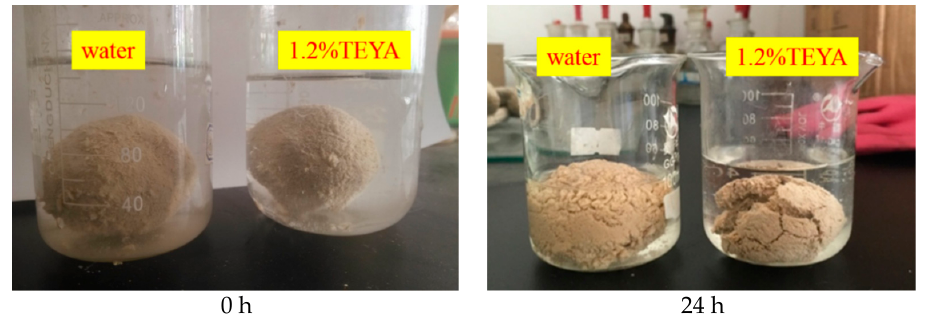
Figure 2. The status of mud balls immersed in different fluids.